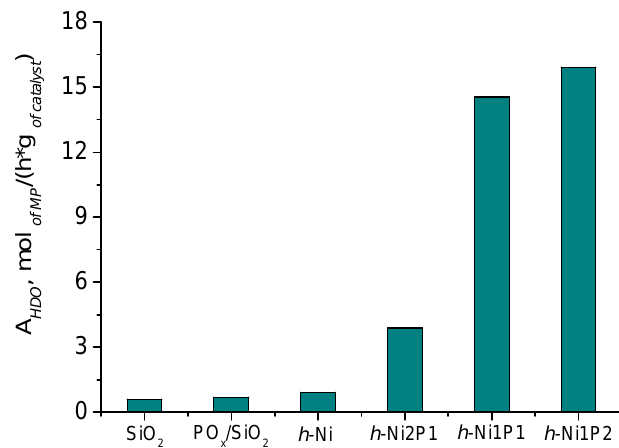
Figure 10. Evolution of the A HDO (mol of MP /h · g of catalyst ) with the nature of the catalyst: h -Ni, h -Ni2P1, h -Ni1P1, h -Ni1P2 and the reference samples SiO 2 and PO x /SiO 2 . Reaction conditions: P H2 = 3.0 MPa, T = 290 ◦ C, H 2 /feed = 600 Nm 3 /Nm 3 , LHSV = 0.3–6.4 h − 1 .